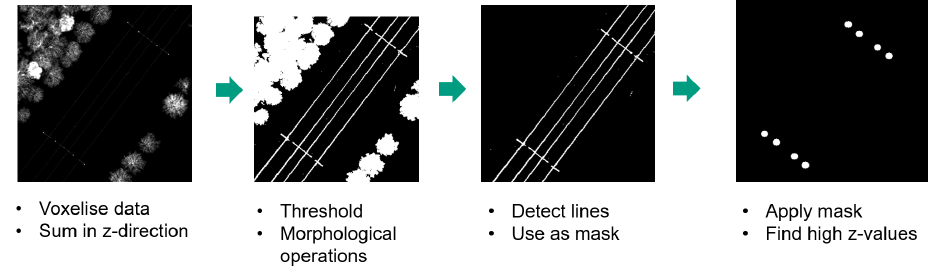
Figure 2. Processing steps for locating catenary arches within a large scene.